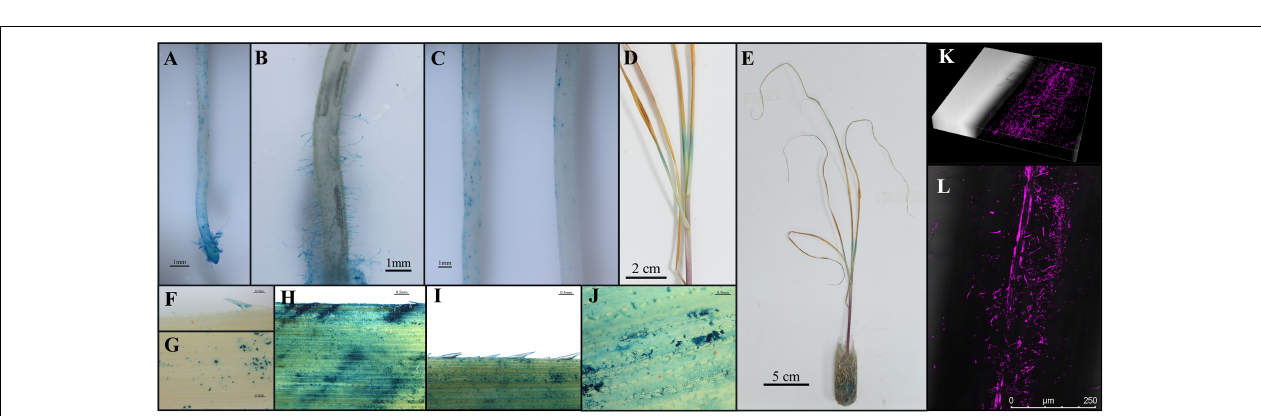
FIGURE 4 | Results of applying potentially beneficial microbes in a field experiment. (A) Growth performance of single stem of sugarcane plants in the field trial 120 days after inoculation with microbial isolates, bar = 50 cm. (B) Biomass of single stem of sugarcane under differnet treatment conditions. Total nitrogen content (C) , phosphate content (D) , and potassium content (E) of sugarcane plants under different microbial applications under field conditions. Different letters indicate significant differences among different treatments in Duncan’s multiple range comparison test.